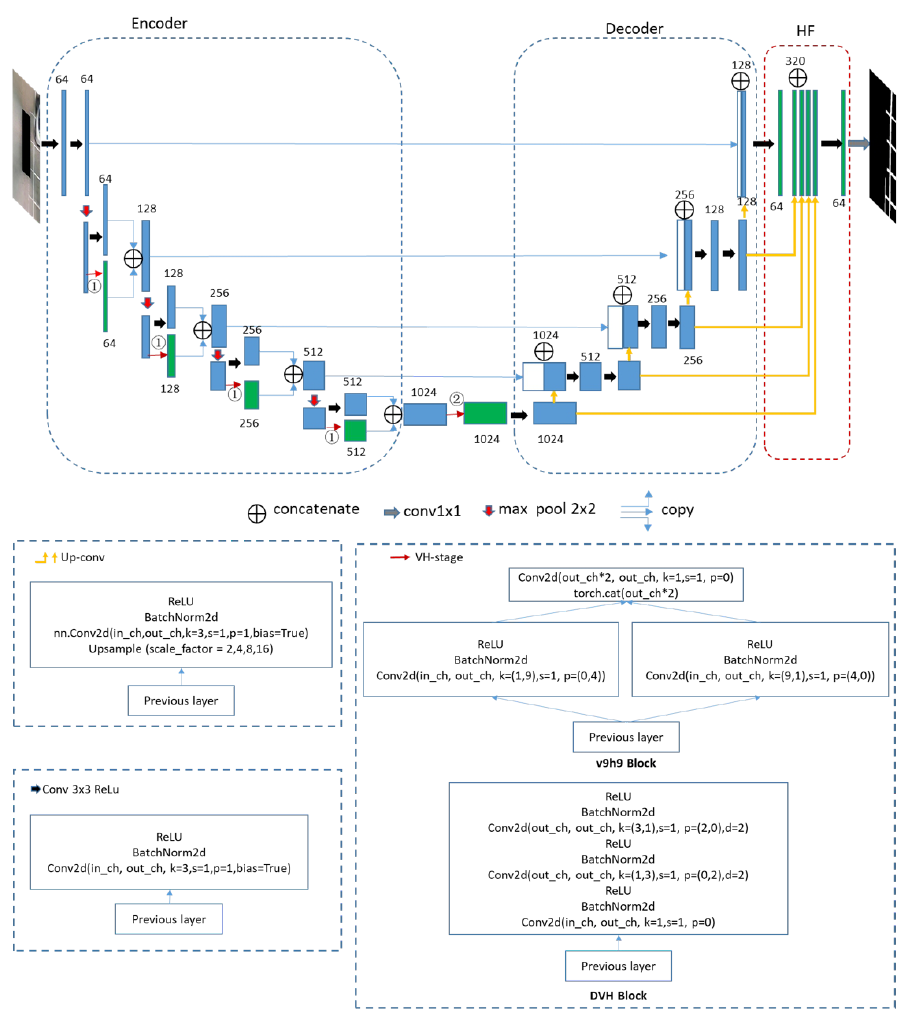
Figure 1. An overview of the proposed structure of segmentation network. An extra HF modile, which was proposed in [36], is added behind each upsampling layer of the Unet. In addition, we changed the Unet basic structure in 1 (cid:13) and 2 (cid:13) , and putt our spatial horizontal and vertical convolution blocks at these places. The green rectangle represents the convolutional layers we added. The conv1x1 represents the convolution with a kernel size of 1 × 1. It will not change the input feature map size. There are two different blocks in the VH-stage: v9h9 block and DVH block. We only use one of them in the VH-stage; the v9h9 block contains the vertical and horizontal convolution with a kernel size of 9 × 1 and 1 × 9, respectively. The DVH block consists of the vertical and horizontal convolution with a kernel size of 3 × 1 and 1 × 3, respectively. The dilatation rate is 2. The Up-conv contains an upsample layer, and the scaling factor is a multiple of